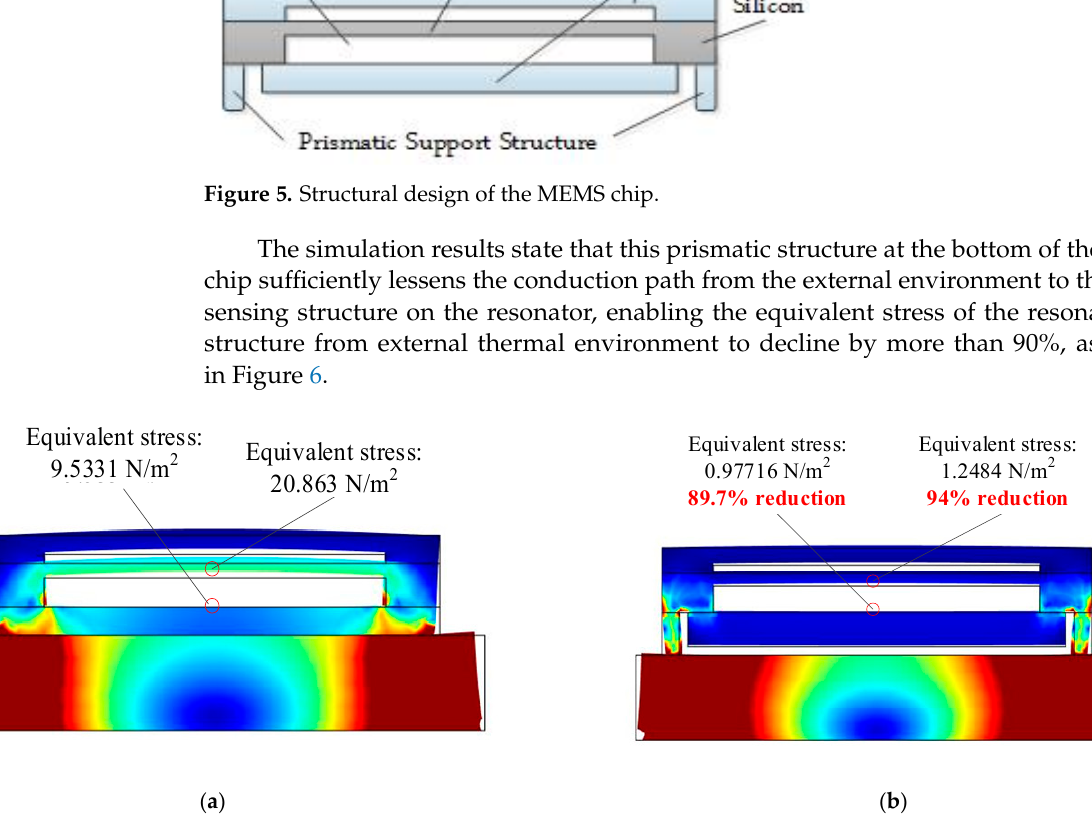
Figure 6. The simulation results of the equivalent stress between two kinds of chips: ( a ) the traditional MEMS chip; ( b ) the MEMS chip proposed in this paper.